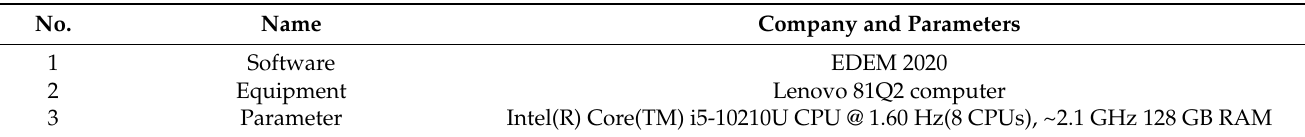
Table 4. Discrete element simulation test